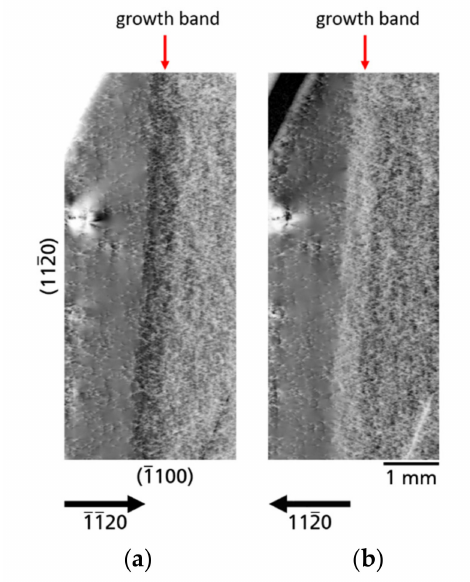
Figure 9. Topographs of the same crystal area of substrate A imaged with diffraction vectors g pointing in opposite directions; ( a ) 1120 reflection and ( b ) 1120 reflection. The bright-dark contrasts in the growth band area are caused by a slight bending of the lattice plane and are reversed for the used two